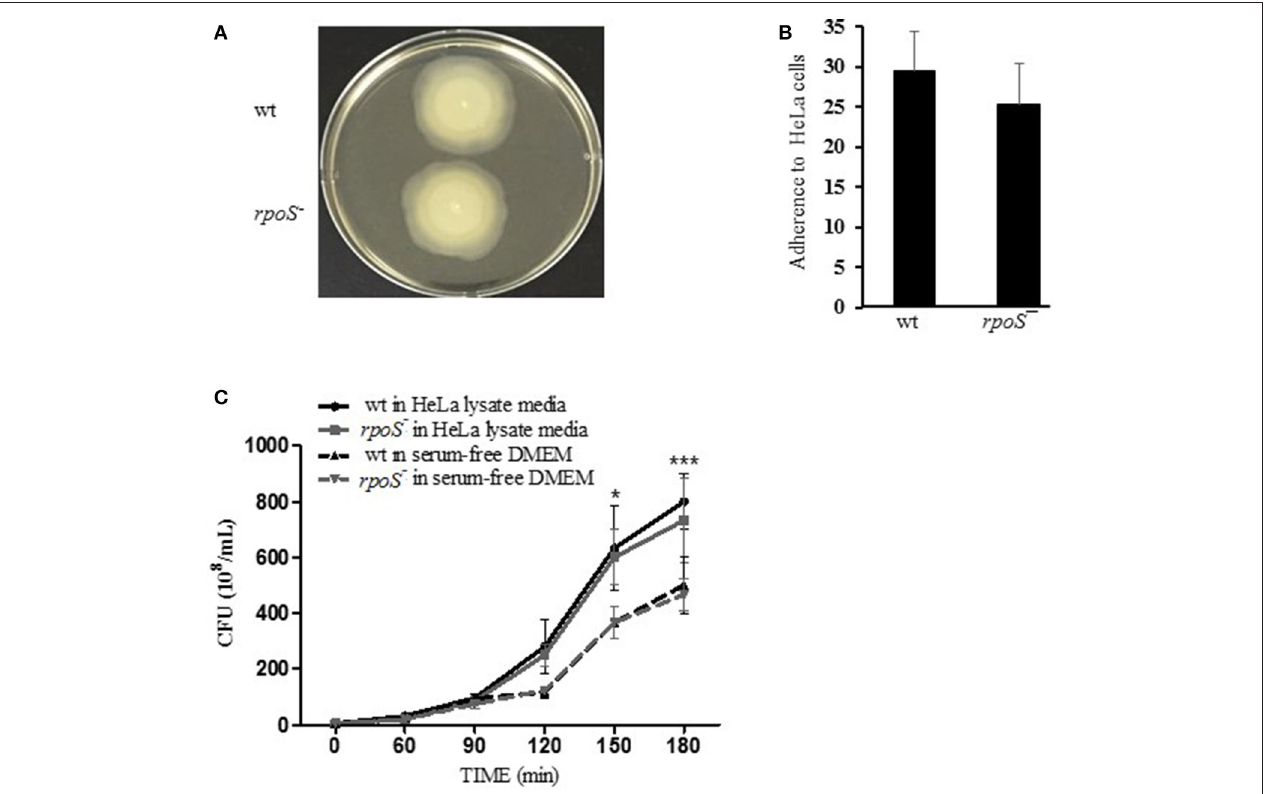
FIGURE 2 | Comparable ability of wild-type and rpoS mutant strains on bacterial growth, motility, and adhesion. (A) To test swarming motility, the fresh cultured bacteria were inoculated by toothpicks on 0.3% semisolid HI agar plates, and incubated at 37 ◦ C incubator for 8h. (B) To test bacteria adhesion, HeLa cells were incubated with V. vulnificus cells at an MOI of 250 for 30min. The host cells were washed thoroughly and stained with Giemsa solution. The bacterial cells adhered to 90 HeLa cells were counted and calculated as the average number of adhered bacteria per HeLa cell. (C ) To test bacterial growth, V. vulnificus wild-type or rpoS mutant bacteria were inoculated into DMEM or the HeLa lysate media (10 8 CFU/mL) and incubated in a 5% CO 2 incubator at 37 ◦ C for 3h. The V. vulnificus culture suspensions were 10-fold serially diluted with PBS, and the serial dilutions (10 µ L) were loaded on HI agar plates overnight. The results represent are means ± SD (vs. V. vulnificus wild-type in free DMEM, * P < 0.05, *** P <